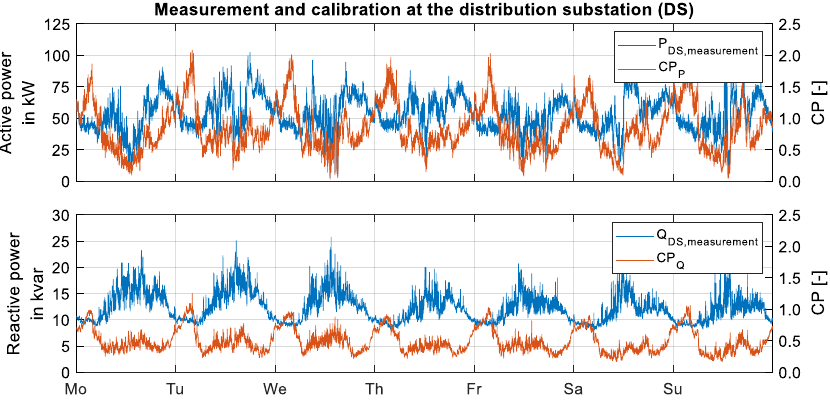
Figure A1. Measured load profiles and calibration parameter (CP), including active and reactive power, considering the suburban LV grid’s distribution substation (DS).